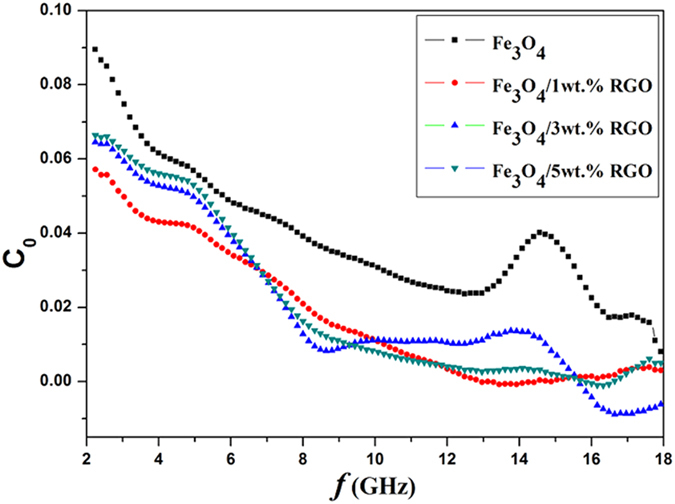
The frequency dependences of C0-f curves for the nanocomposites.